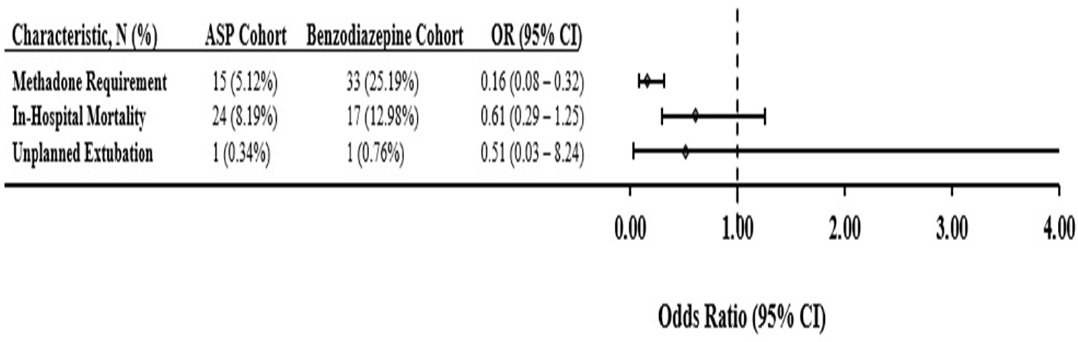
Figure 1. Comparison of odds for adverse events between ASP cohort and Benzodiazepine cohort. Legend: This forest plot compares odds ratios for methadone requirement, un- planned extubations, and mortality between the analgosedation cohort and the benzodi- azepine cohort. Table 3. Comparison of Outcomes between ASP cohort and Benzodiazepine cohort. Duration